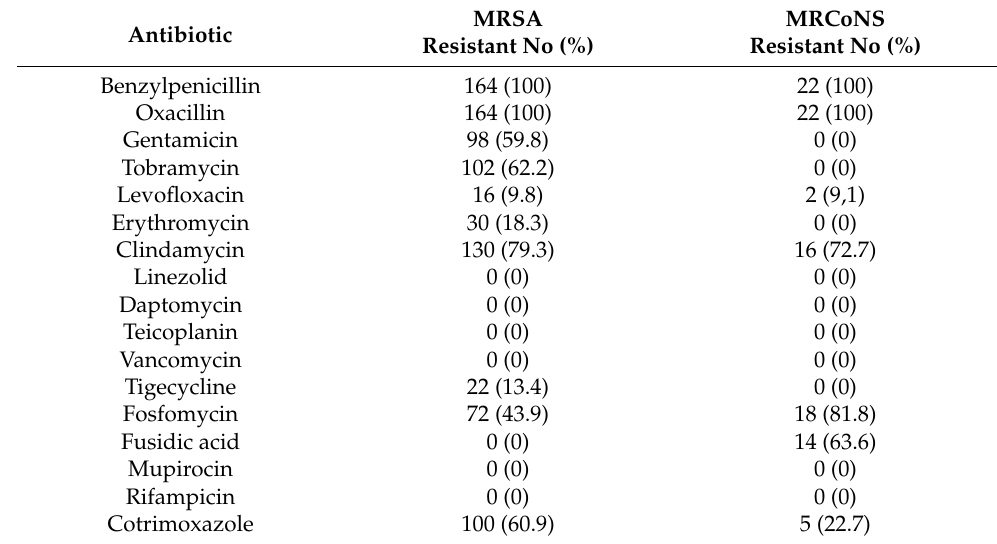
Table 2. Percentage of resistance to the antibiotics tested presented by the isolated MRS strains.